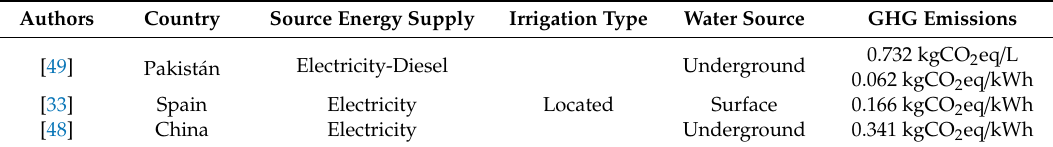
Table 7. Review of published values for emissions per m 3 of irrigation